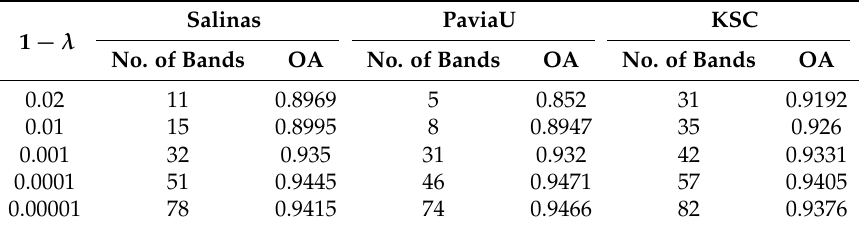
Table 5. Classification overall accuracy (OA) and the number of bands with different values of threshold λ , where (1 − λ ) is the alternative to emphasize the magnitude variation of threshold values.